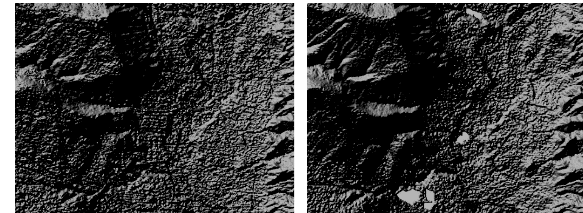
Figure 1. Shaded relief representation of two DEMs of the same area, produced by different technologies and at different times: gaps in the representation of the relief of physical phenomena in location, both in height and in